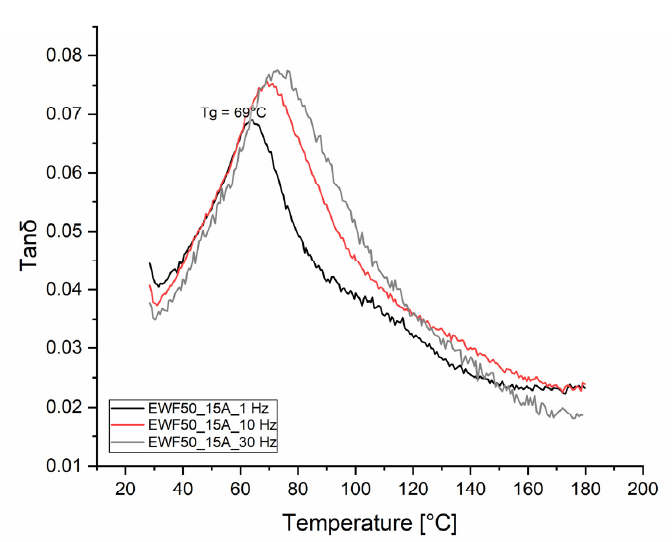
Figure 13. Tan δ vs. temperature of the polymer obtained from the recycling of the EWF50_A15 formulation.